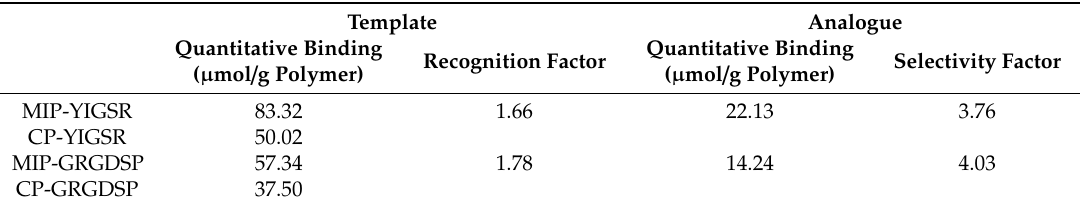
Table 3. Results of recognition and selectivity tests, performed on MIP-YIGSR, MIP-GRGDSP, and relative controls (CP-YIGSR and CP-GRGDSP,